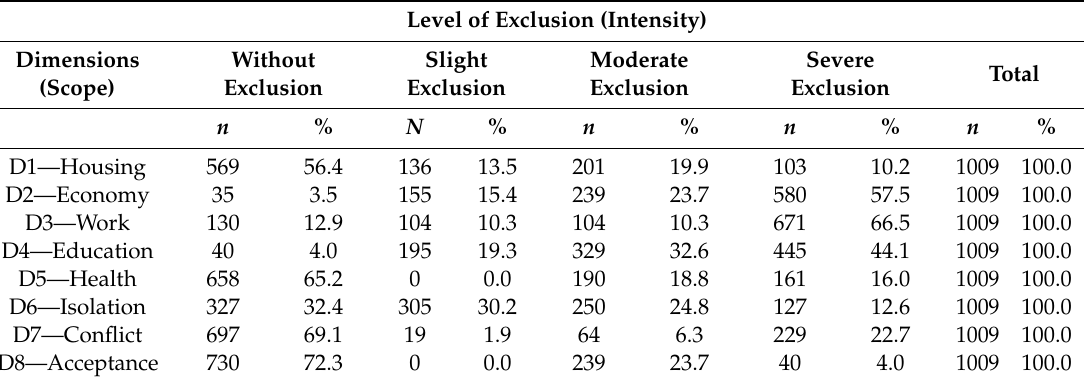
Table 1. Intensity and Scope of Social Exclusion ( n , %). Level of Exclusion (Intensity)